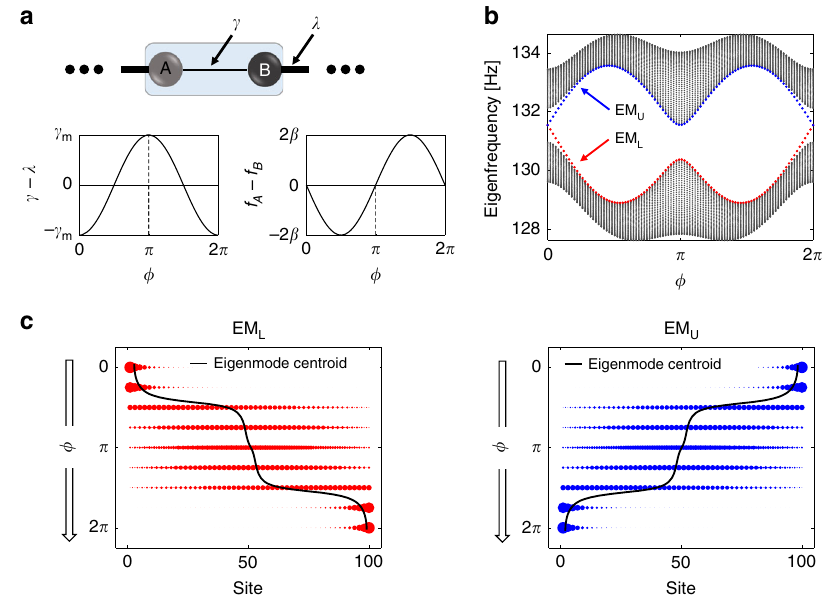
Fig. 1 Description of the topological pump. a A unit cell of a dimerized 1D array (sub-lattice sites A, B) having on-site potential f A , f B , intra-cell coupling γ and inter-cell coupling λ . The pump is produced by modulating the intra-cell coupling with a cos ð ϕ Þ trend, and modulating the on-site potentials with a sin ð ϕ Þ trend, where ϕ ∈ [0, 2 π ] is the pump phase. b Calculated band-structure for an array composed of 100 sites, as a function of the pump phase ϕ . EM U and EM L are the upper and lower trajectories over which the two edge modes evolve during the pump cycle. At ϕ = 0, 2 π the system is in the topologically non-trivial phase while at ϕ = π the system is in the topologically trivial phase. c Evolution of the EM L (red) and EM U (blue) eigenmodes during the pump cycle. Dots represent the magnitude of the eigenmode at each site. EM L is localized on the left edge at ϕ = 0 and transports to the right edge. In contrast, EM U is transported from the right edge to the left edge. The solid black line represents the centroid of the eigenmode calculated through ∑ i i ⋅ ψ mi where ψ mi is the normalized weight of the m th eigenmode at position i